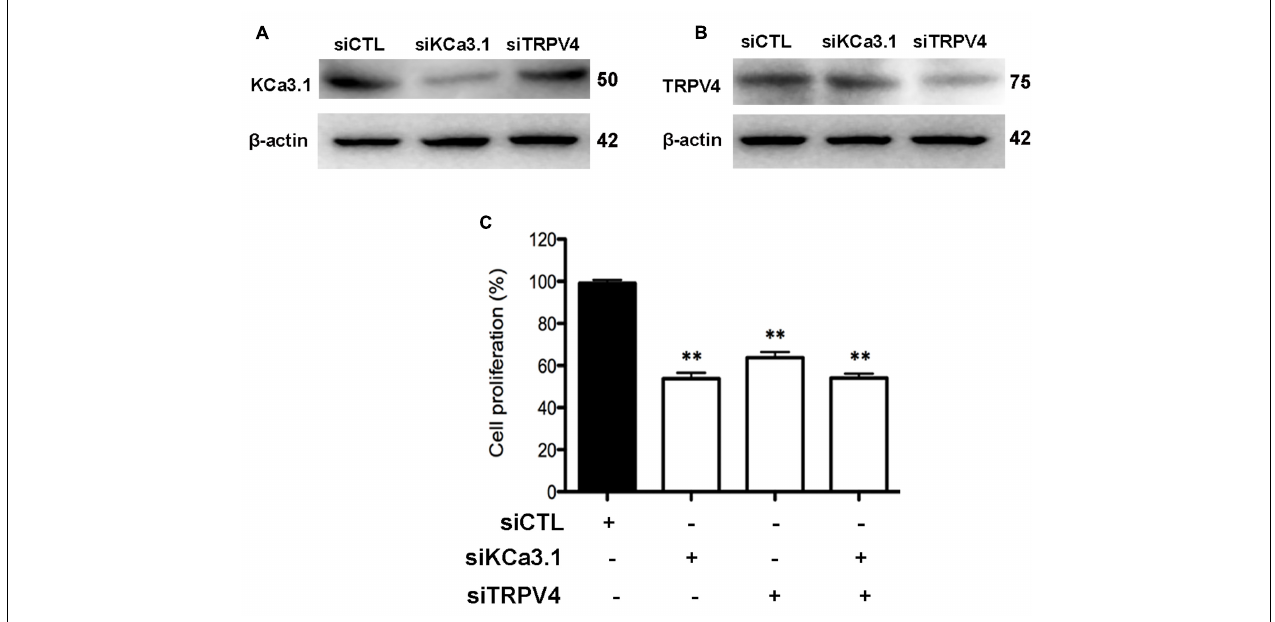
FIGURE 8 | KCa3.1 and TRPV4 involvement in HBSM cells proliferation. (A) Representative western blot showing the effect of siRNAs directed against KCa3.1 and TRPV4 on the protein level of KCa3.1. (B) Representative western blot showing the effect of siRNAs directed against KCa3.1 and TRPV4 on the protein level of TRPV4. (C) Analysis of HBSM cells proliferation transfected with siCTL, siKCa3.1, or siTRPV4. Cell proliferation (CCK-8 assay) was measured as described in methods 72 h post-transfection. Values were reported as means ± SEM normalized to the control ( n = 4). ∗∗ p < 0.01, one-way ANOVA followed by the Dunnett’s multiple comparison test compared with siCTL. CTL,